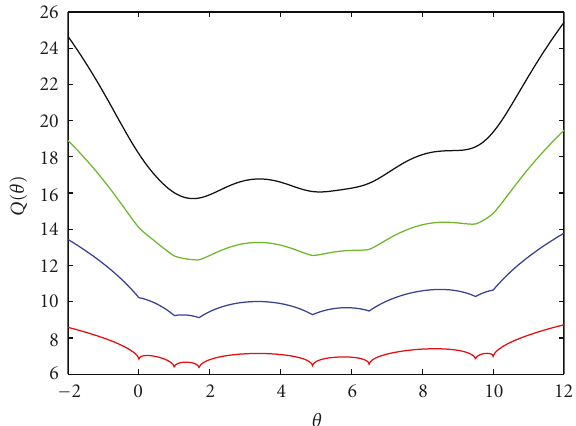
Figure 1: Typical M-GC objective functions for di ff erent values of p ∈ { 0 . 5, 1, 1 . 5, 2 } (from bottom to top respectively). Input samples are x = [4 . 9, 0, 6 . 5, 10 . 0, 9 . 5, 1 . 7, 1] and σ =